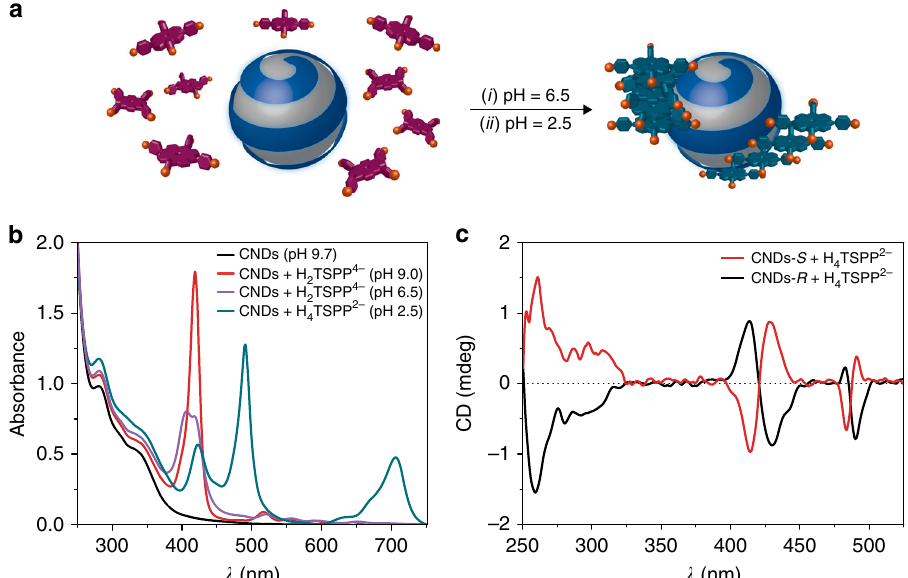
Fig. 5 CNDs- S or CNDs- R as templates for chiral supramolecular aggregates. Experiments performed in water at 298 K. a Schematic representation of CNDs- R acting as chiral template after pH decrease trigger (purple = free base porphyrin, green = protonated porphyrin); b UV – Vis spectra of CNDs (black line) and CNDs + H n TSPP m- solutions at different pHs (H 2 TSPP 4- concentration = 6.0 μ M); c ECD spectra of CNDs- S (red line) and CNDs- R (black line), both in the presence of H 4 TSPP 2- (6.0 μ M) at pH =